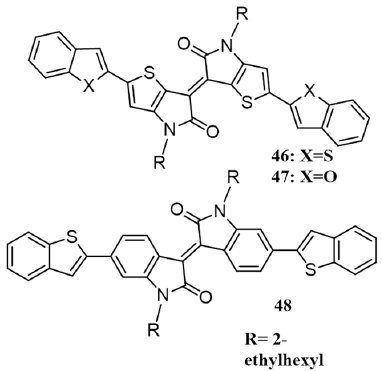
Figure 17. The chemical structures of 46 – 48 synthesized by Mori et al. [67].